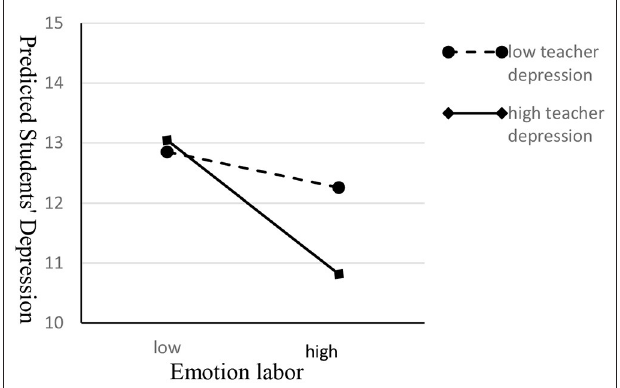
FIGURE 1 | The interaction between teachers’ depressive symptom and deep acting of emotional labor. As the root squared values of the students’ depressive symptoms was used as the dependent variable, we squared the predictive values of the students’ depressive symptoms.